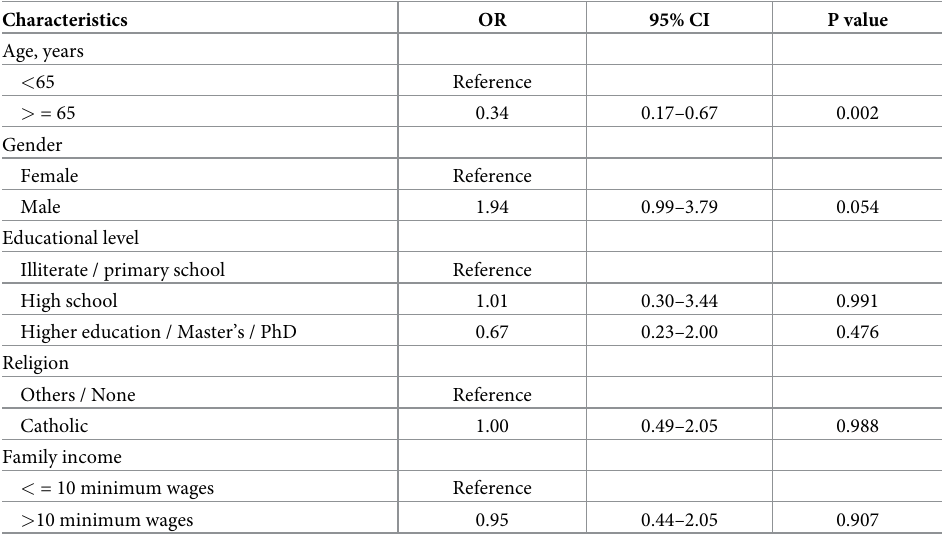
Table 3. Multivariate logistic regression analysis addressing patients’ characteristics associated with their willing- ness to participate as volunteers in a scientific study.